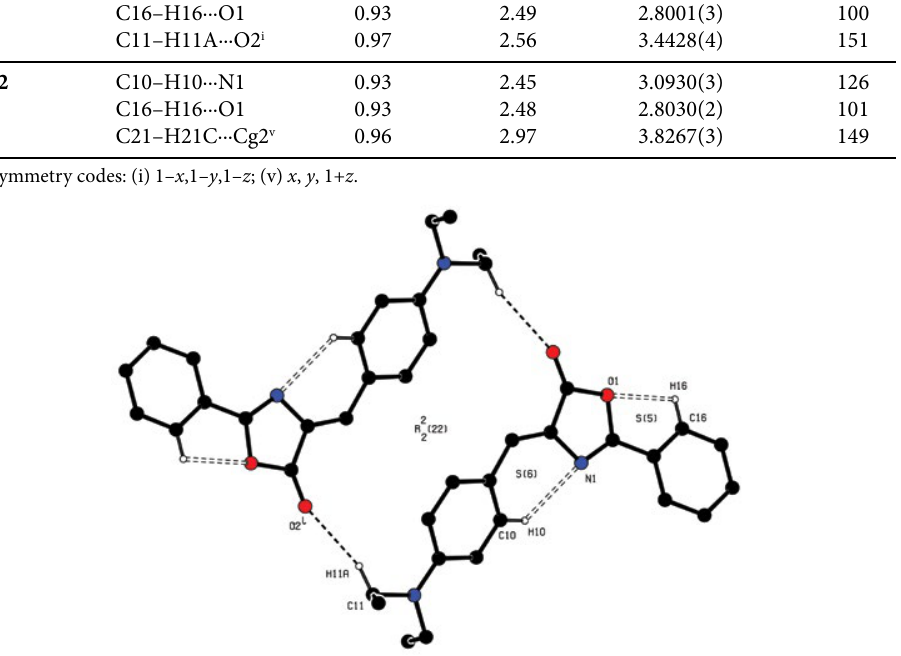
Figure 2. The formation of the hydrogen bond motif through C11–H11A∙∙∙O2 i hydrogen bonds for the compound 1 [ i 1+ x , 1+ y , + z ]. For the sake of clarity, H atoms not involved in the motif have been omitted, and only the interacting atoms are